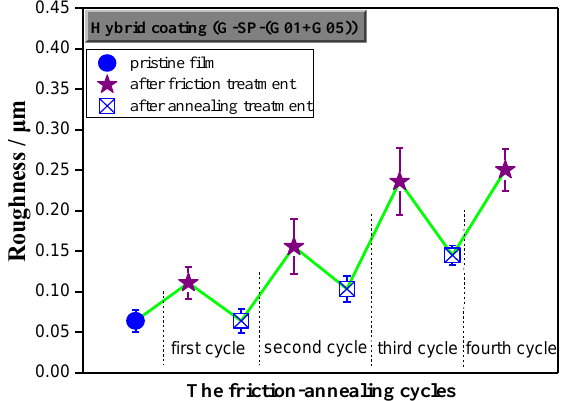
Figure 8. Roughness change for hybrid coating film with 2 wt.% G-SP-(G01+G05) during the abrasion–annealing cycle.